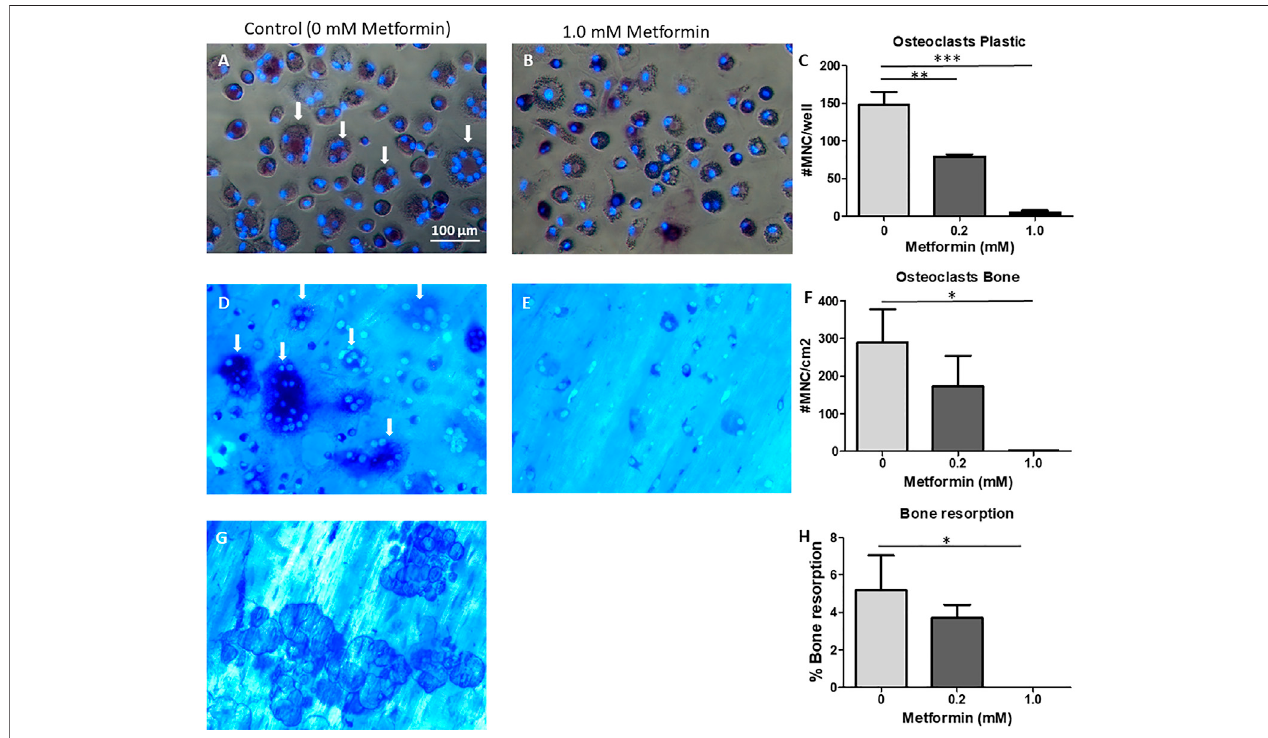
FIGURE 4 | Metformin inhibits M-CSF and RANKL driven osteoclast formation. CD14 + cells as source of osteoclast precursors were seeded on plastic (A – C) , or on bone (D – H) and cultured with M-CSF and RANKL, without or with 0.2 or 1.0 mM Metformin. Micrographs of cells on plastic (A,B) or on cortical bone slices (D,E) or bone resorption pits (G) . Quanti fi cation of cell counts on plastic (C) , bone (F) . (H) : Quanti fi cation of bone resorption. Quantitative data were from quadruplicate seeding. *: p < 0.05; **: p < 0.01; ***: p < 0.001. Scale bar in A applies to all micrographs. Arrows point to TRAcP multinucleated cells/ osteoclasts.